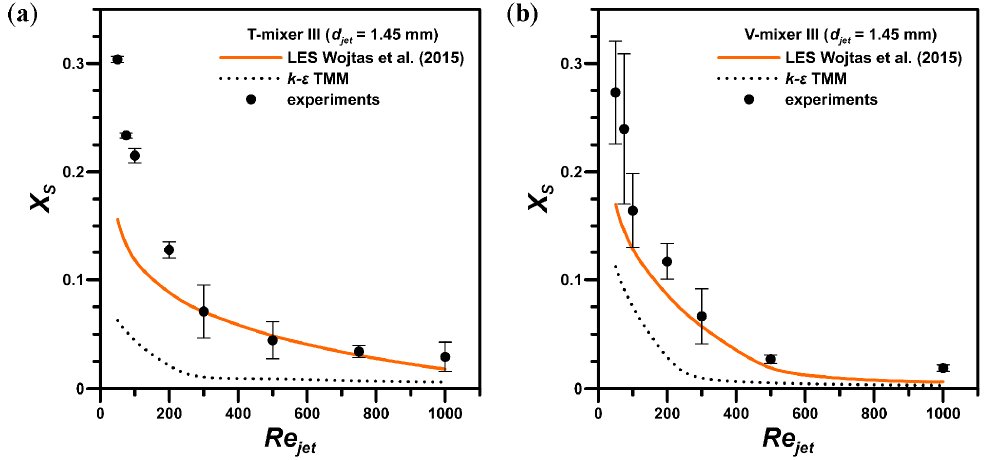
Figure 5. Parity plot showing predictions of the large eddy simulation (LES) and Reynolds-averaged Navier–Stokes (RANS) models: ( a ) V-mixer I; ( b ) V-mixer II. Figure 6. The effect of the jet Reynolds number on the final selectivity of the chemical reaction: ( a ) T- mixer III; ( b ) V-mixer